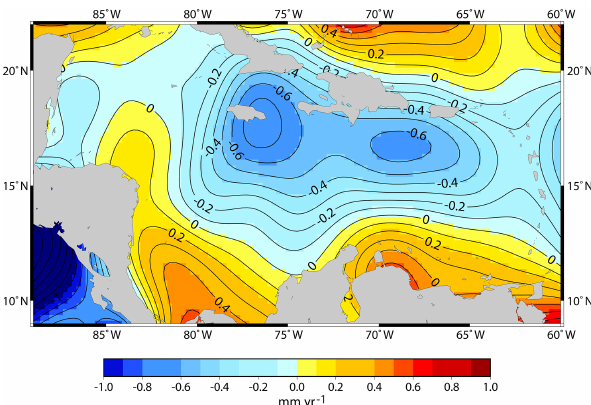
Figure 5. Sea level trends in the Caribbean basin (whereas the global mean trend of 3 . 00 ± 0 . 4mmyr − 1 is removed), calculated using satellite altimetry data